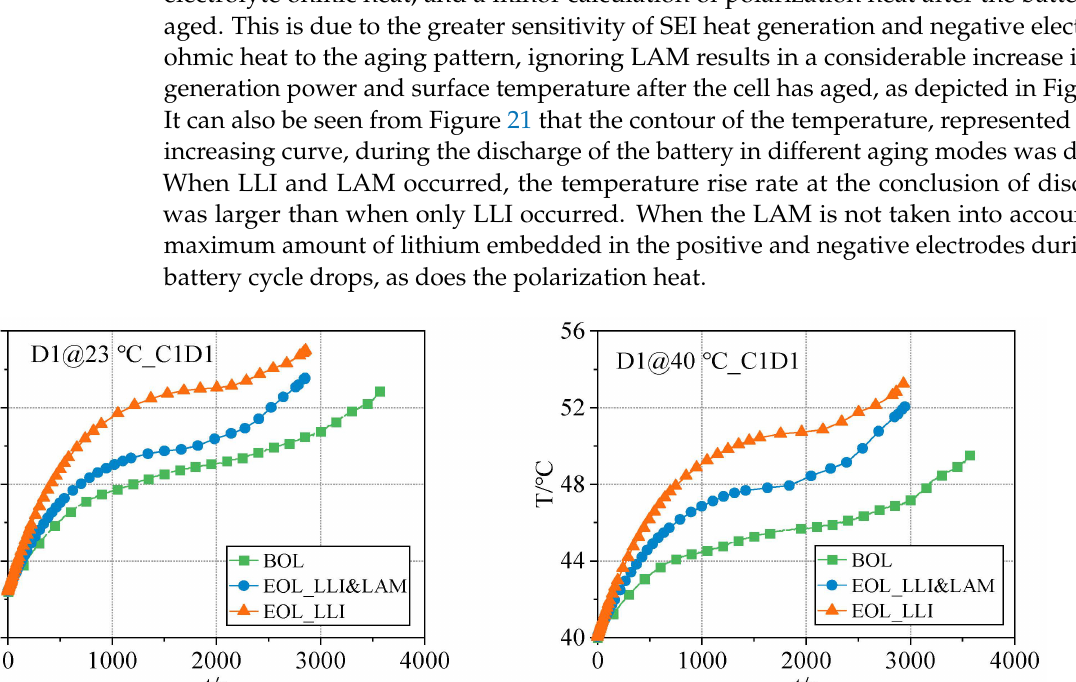
Figure 20. Variations in electrode SOC during the aging process when only LLI occurred in the cell at ( a ) 23 °C and ( b ) 40 °C.